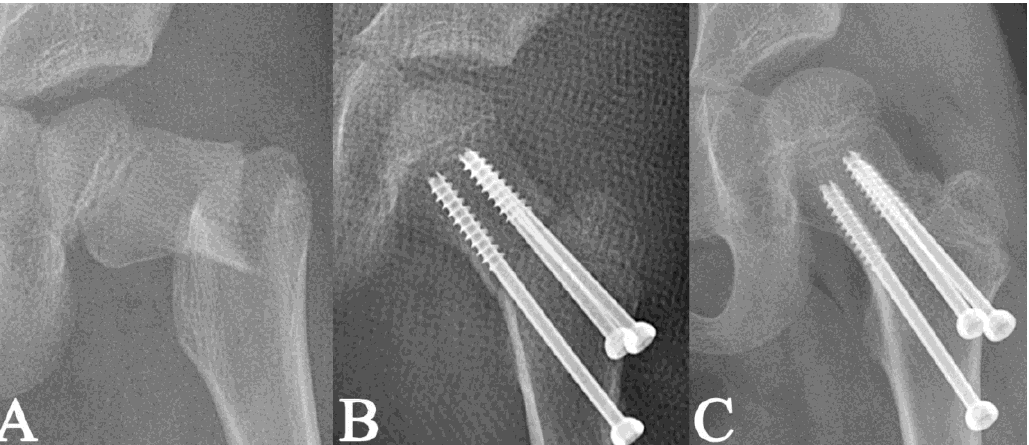
Figure 6. Radiographs of a 5-year-old girl with a displaced Delbet – Colonna type II fracture [15] ( A ); radiographs after closed reduction and internal fixation with 3 cannulated screws ( B ); the radiological healing at 3.9 months post-surgery ( C ).